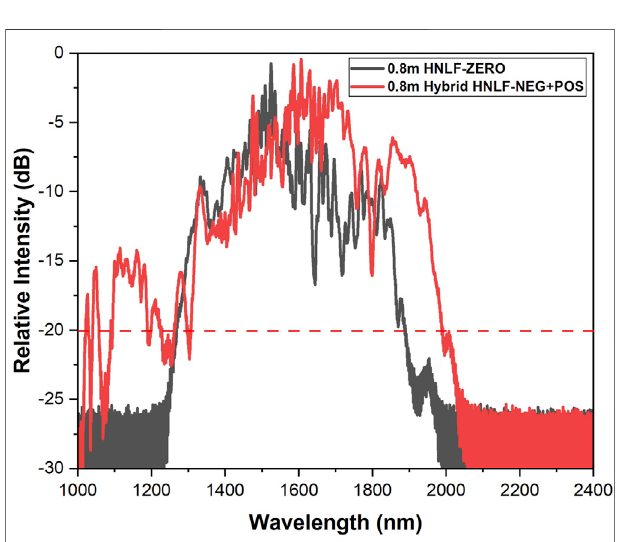
FIGURE 7 | Comparing the spectra generated by the 0.8 m HNLF with zero dispersion (black line) and the hybrid HNLF with positive and negative dispersion (red line).